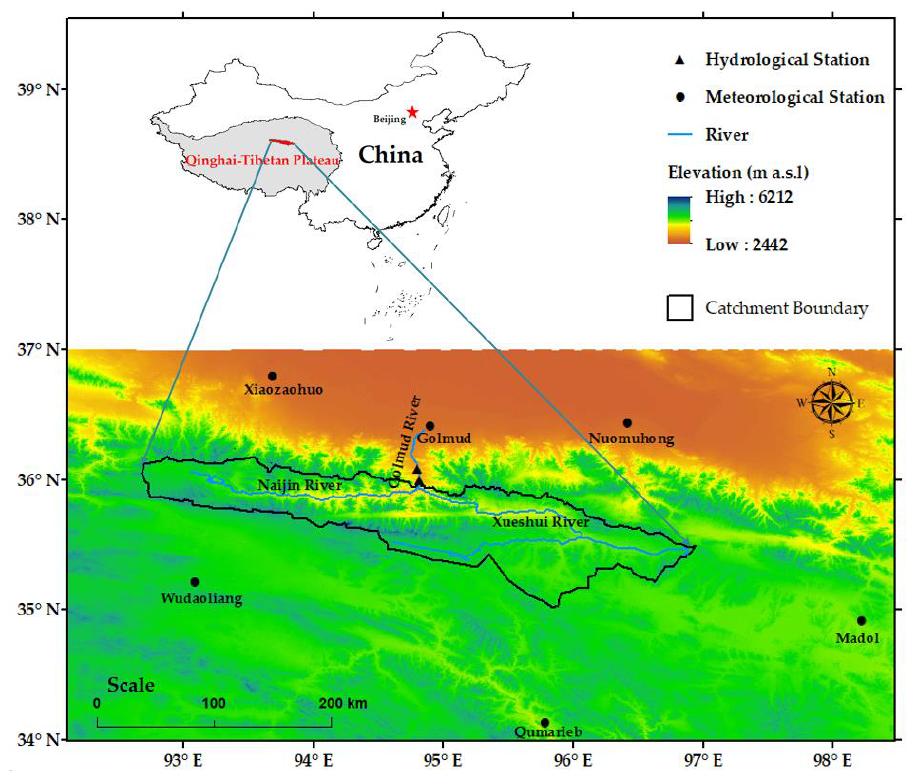
Figure 1. Study area and locations of the meteorological and hydrological stations.